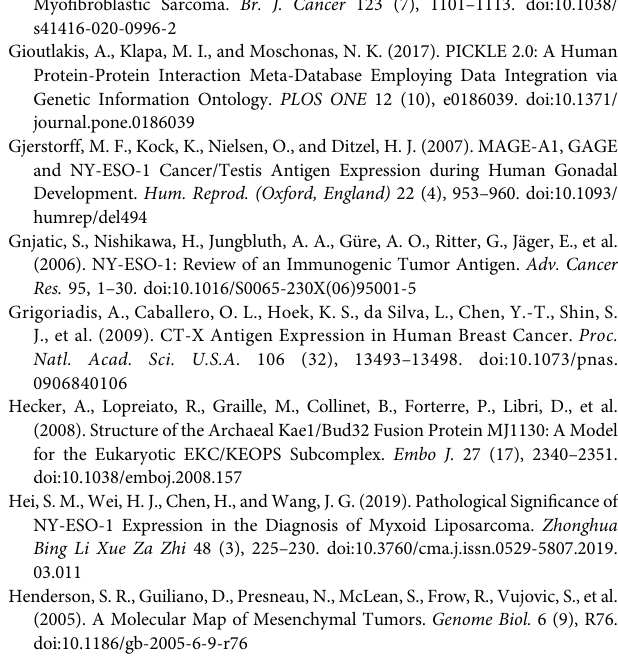
Supplementary Figure S1 | (A) Upper left panel. Top fi fty genes identi fi ed with GSEA that show positive (CTAG1_POS) or negative (CTAG1_NEG) patterns of co-expression with ctag1b/a. Ctag1b/a (middle of Figure, left panel) was used as an index gene to compute the statistical distance of the other genes with GSEA as described in Computational section. Genes at the top and bottom are the most distant whereas those nearest ctag1b/a are those with the highest index of correlation (details in Supplementary Material ). Upper right panels. Top enriched pathways of Ctag1_Positive or Negative modules computed as described in the Methods section. (B) Lower left panel: Heat map of gene expression status in phenotypic class lists of ctag1b/a co- expressed genes in microarray datasets retrieved from GEO (Supplementary File S1) . Lower middle panel: Gene setsranked by Kolomogorov-Smirnov (KS) statistics resulting from comparison with the MSigDb (GSEA site, MIT) and with the Papanikolaou gene sets collection. Lower right panel: Computed ES score for genes lists and rank in ordered